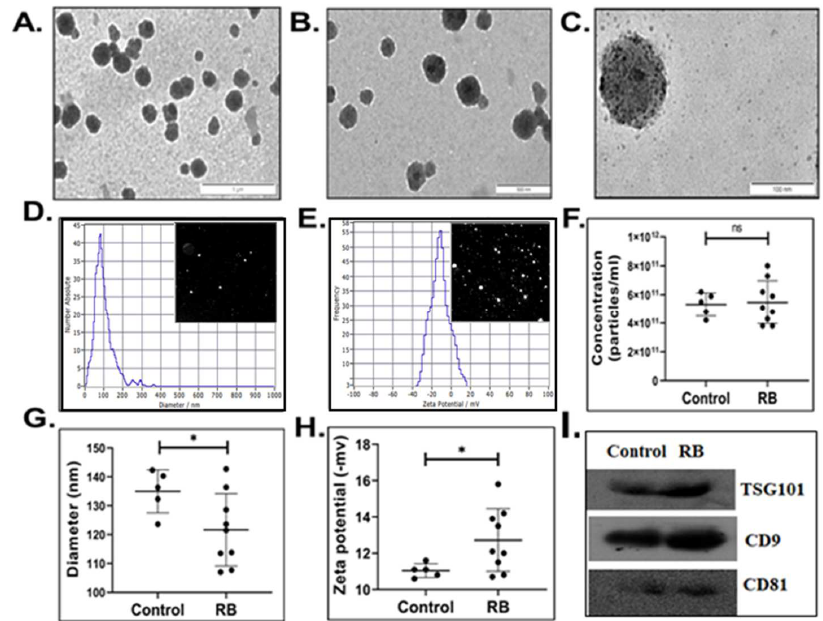
Figure 1. Representative transmission electronic images of small EVs (sEVs) recovered from Retinoblastoma (RB) RB serum samples. Images were captured at different scales ( A ) 1000 nm ( B ) 500 nm ( C ) 100 nm. ( D ) Size distribution profile and ( E ) Zeta potential of serum sEVs generated by ZetaView ® Nanoparticle Tracking Analyser (NTA). This captures the video data of sEVs moving under Brownian motion in PBS. The video data was then analysed using the NTA software (version 8.05.12 SP1). Dot plots representing ( F ) Concentration (particles/mL), ( G ) size distribution (nm), and ( H ) zeta potential (mV) of RB and non-RB serum EVs. Black circles indicates number of subjects included in each group, * Significance level: p -value < 0.05 calculated by Welch’s T-test, and ns stands for not significant. ( I ) Immunoblotting for exosome specific proteins.